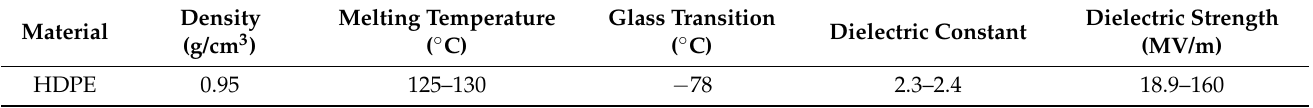
Table 1. Physical properties of CO 2 .